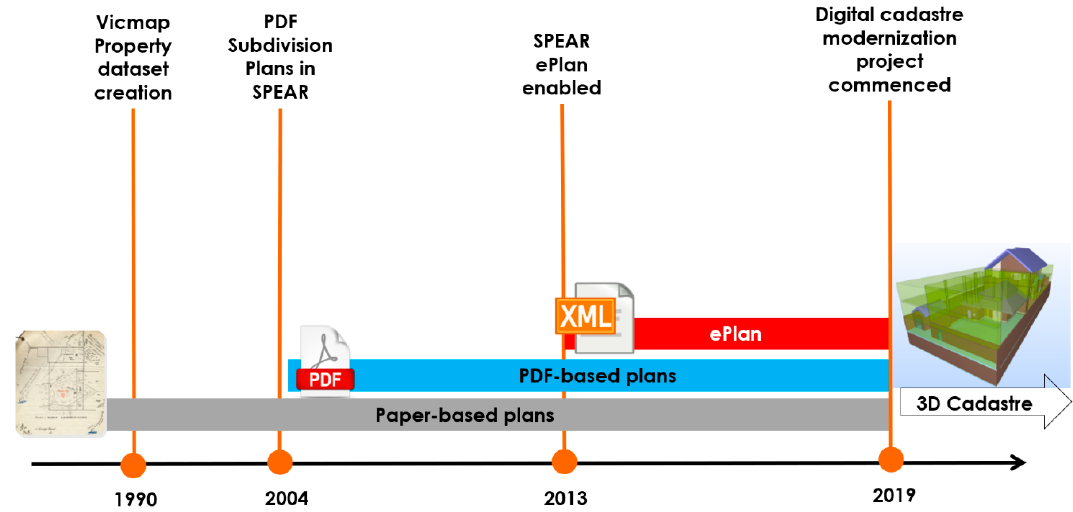
Figure 1. Victorian cadastre modernization journey (modified after [9]).